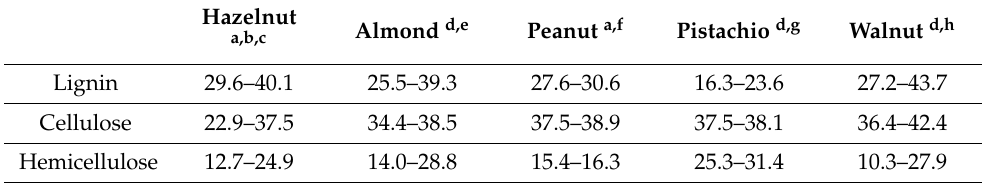
Table 5. Percentage of lignin, cellulose, and hemicellulose in the tested nutshells compiled from literature.